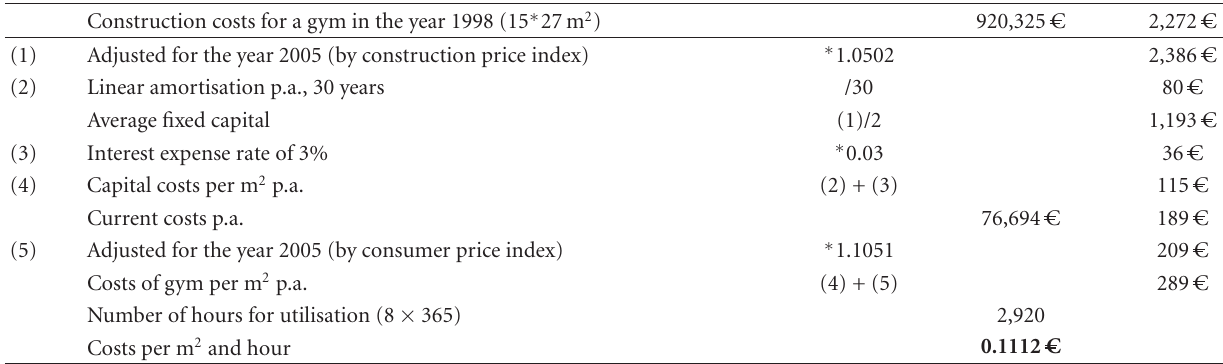
Table 2: Imputed capital costs of the